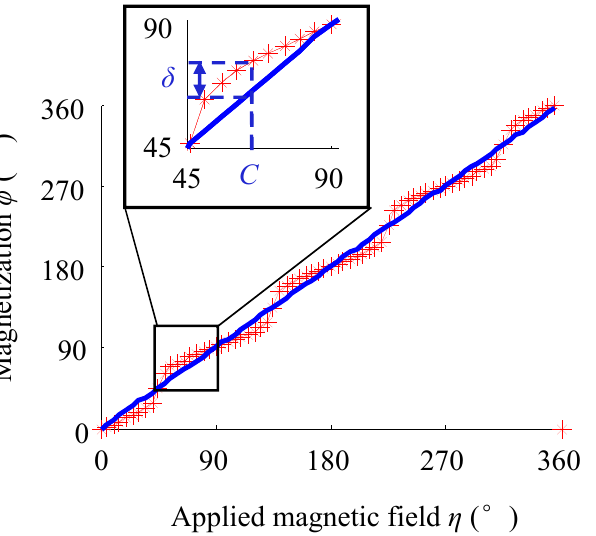
Figure 3. Magnetization direction under the applied magnetic field with different angular positions η .